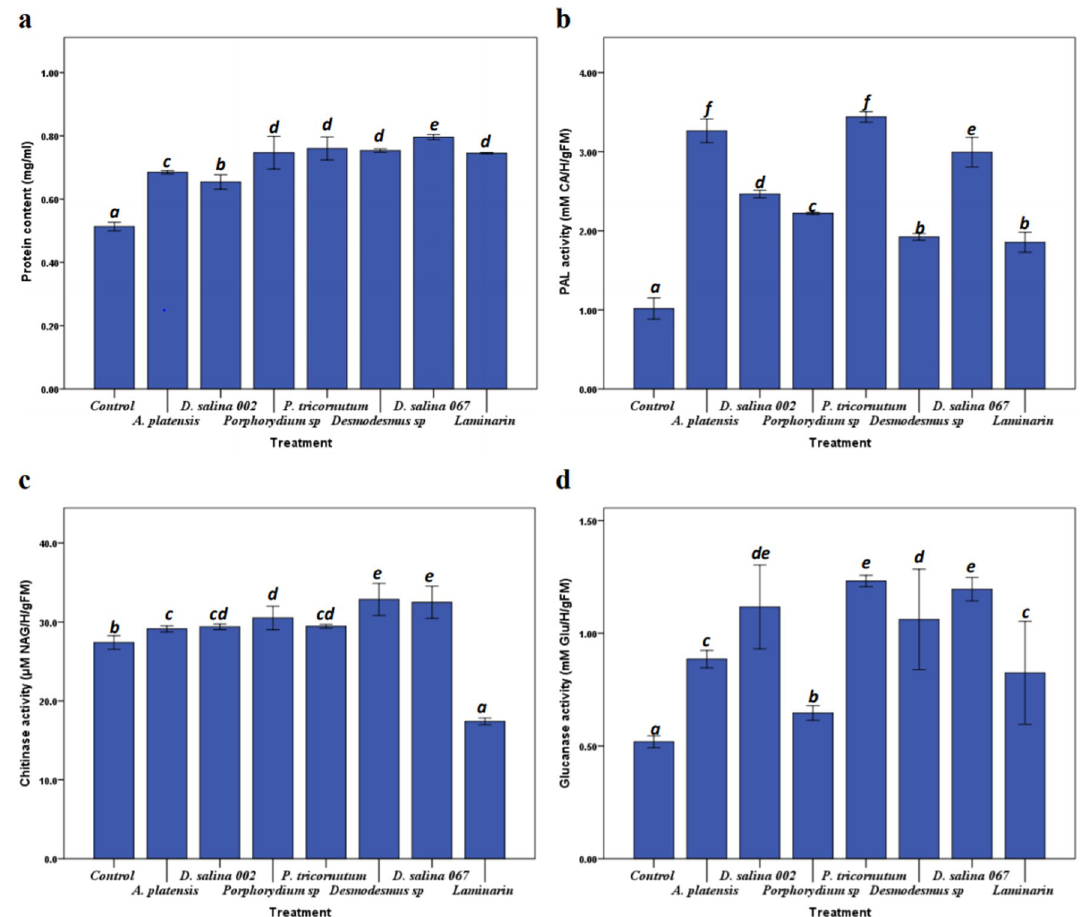
Figure 1. The effect of crude PS on protein content ( a ), PAL ( b ), chitinase ( c ) and β-1,3-Glucanase ( d ), activities. Tomato plants were injected with 1 mg mL −1 of PS. H 2 O and Laminarin (1 mg mL −1 ) were used as negative and positive controls respectively. Values are the mean (± SE) of five replicates. Different letters indicate significant difference between treatments ( p < 0.05) according to Turkey-test, One-way